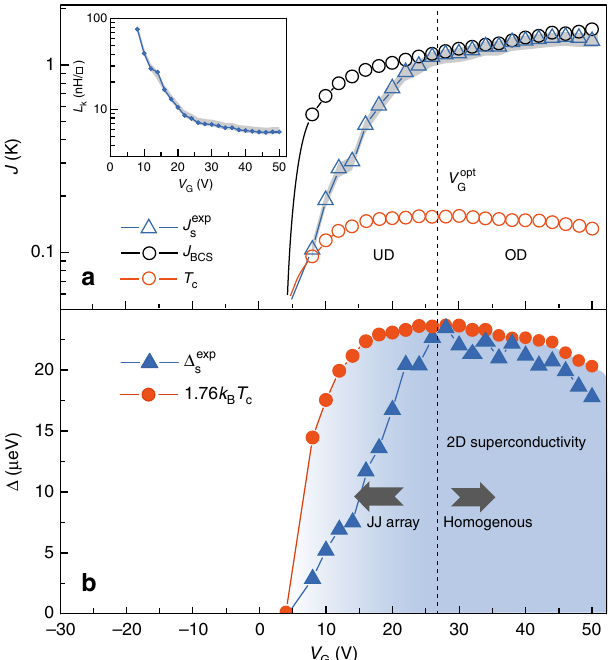
Fig. 4 Super fl uid stiffness and phase diagram. a Experimental super fl uid T ’ 0 ð Þ (open triangles) as a function of V T stiffness J exp G compared with c s taken at R dc = 0 Ω (red open circles), and with the BCS theoretical stiffness J Δ (0) = 1.76 k T BCS expected from Eq. (2) assuming B c (black open circles). The gray outline indicate the total error margin in the determination of J exp ð T ’ 0 Þ . Inset) L ð T ’ 0 Þ as a function of V G and error margin (gray k s ð T ’ 0 Þ as a outline). b Super fl uid stiffness converted into a gap energy Δ exp s function of V G (plain triangles) compared with the expected BCS gap energy 1.76 k B T c (plain